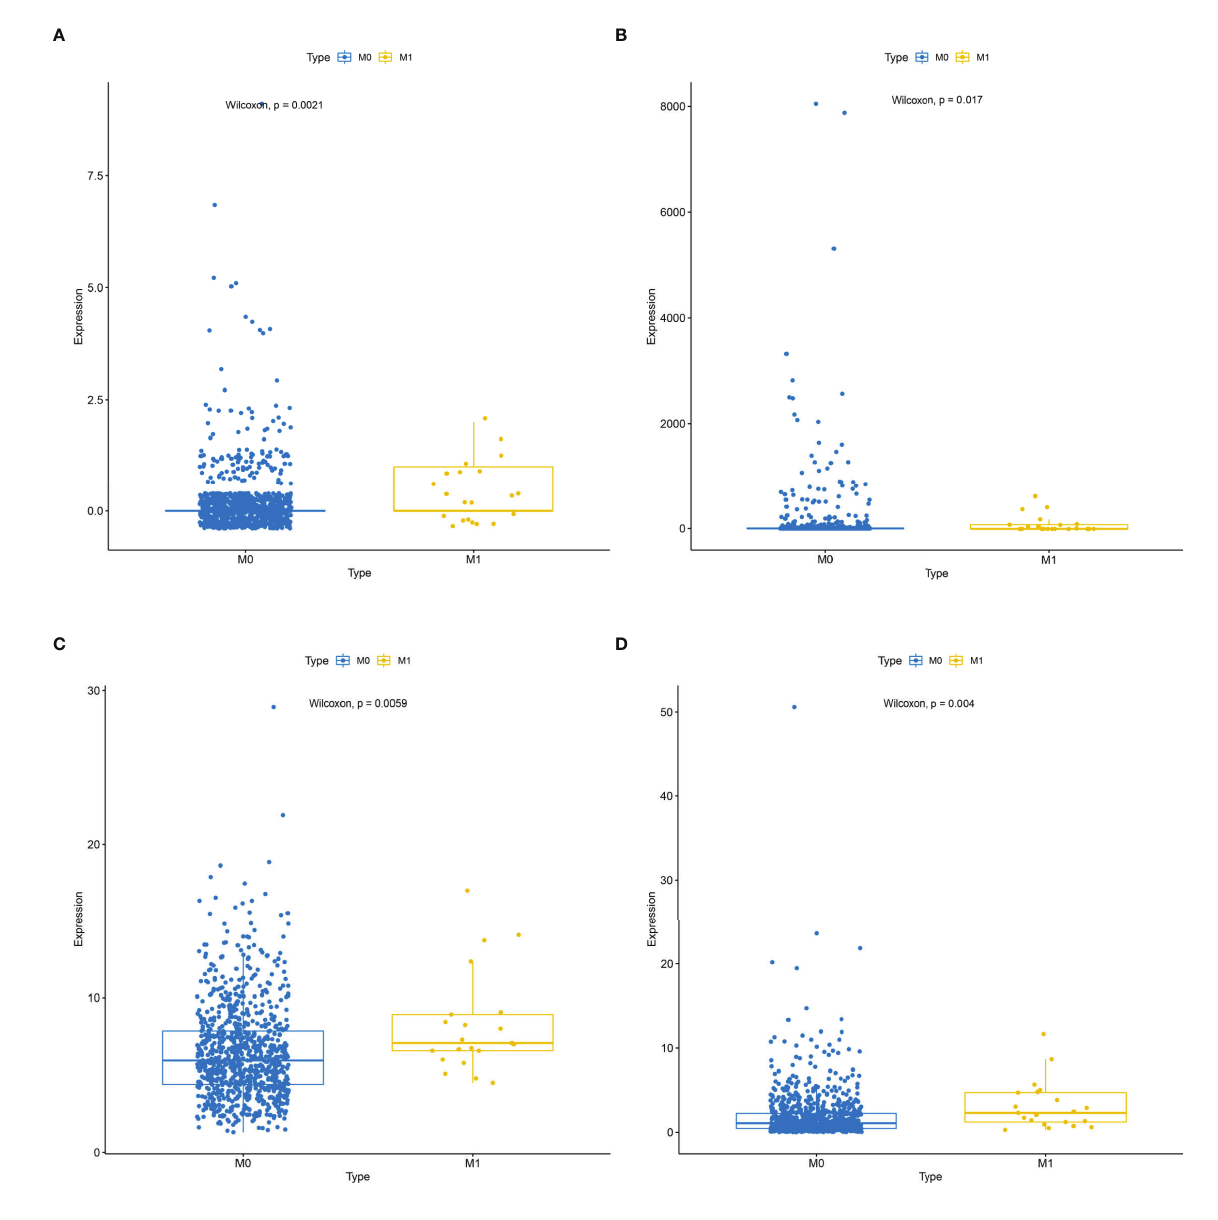
FIGURE 8 | Expression levels of the 4 reliably metastatic biomarkers between M0 and M1 samples. hsa-miR-4435 (A) , hsa-miR-105-5p (B) , BCAR1 (C) , PANX2 (D)